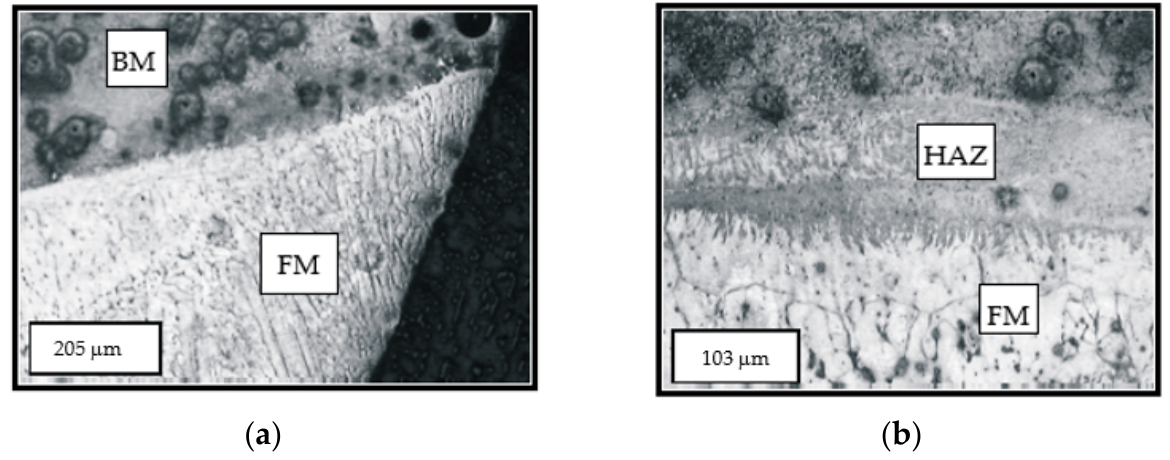
measurement width of 6.615 mm. The measurement results are presented in Table 2 and in Figure 5 [29].